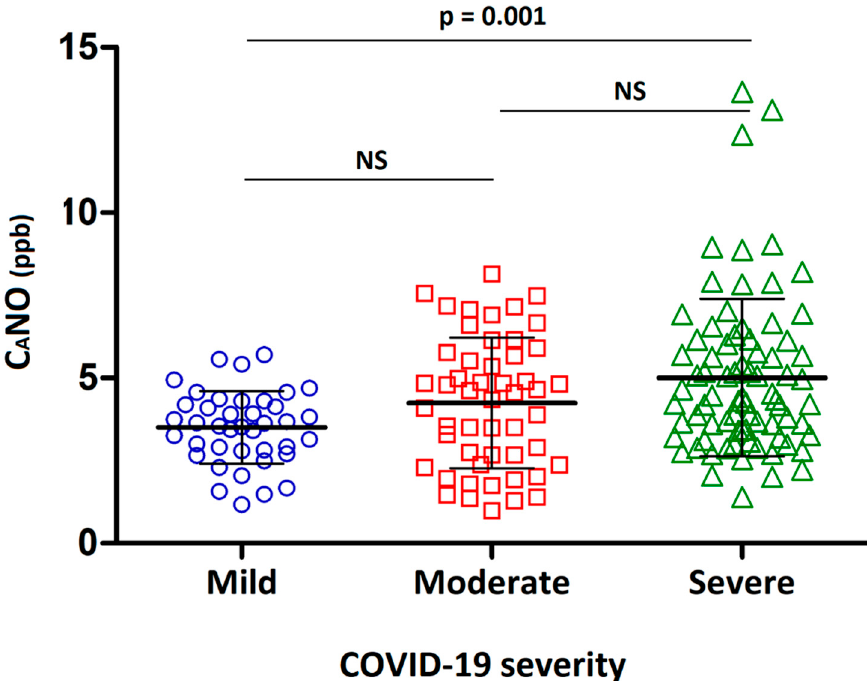
Figure 2. Alveolar concentration of exhaled nitric oxide (CaNO) in patients with recovered SARS- CoV-2 pneumonia.COVID-19 severity was determined as described previously in Materials and Methods (mild disease group with 40 patients; moderate 51 patients; severe 78 patients). For each group, the central thickened black bar presents arithmetical mean of CaNO (ppb) of the group, and two black thin bars present the standard derivations (SDs). Comparison between the three groups was performed using ANOVA analysis coupled with Tukey’s post hoc tests. NS: no statistically significant ( p > 0.05). This figure was drawn using GraphPad Prism version 5.01(GraphPad Software, San Diego, CA, USA) for Windows.